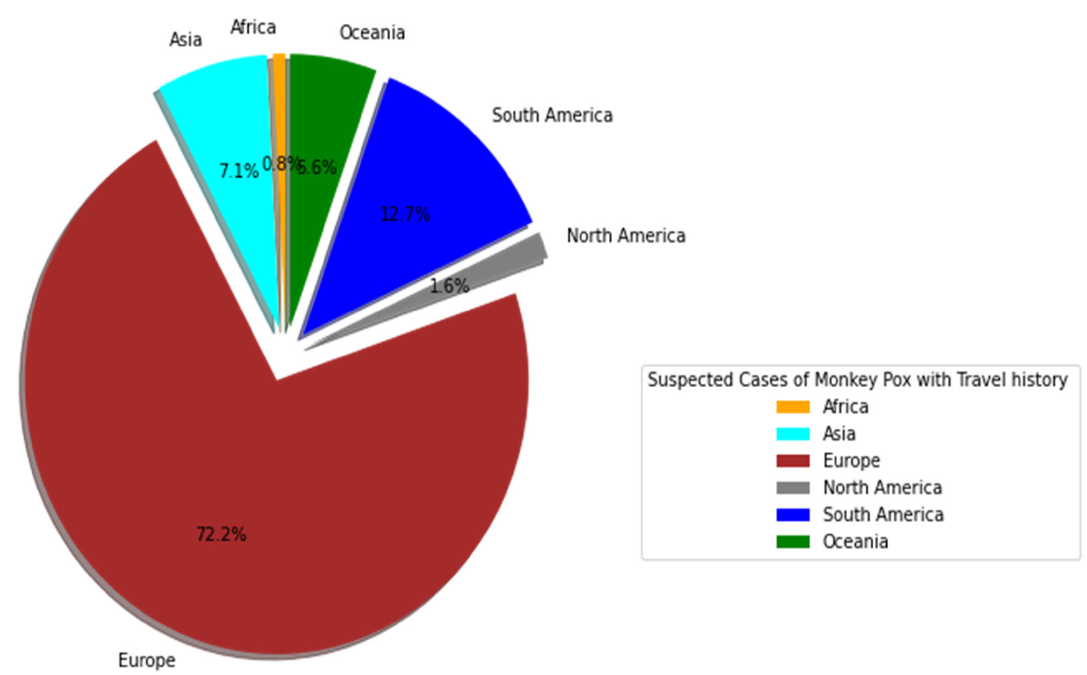
Figure 4. Suspected Cases of Monkey Pox.